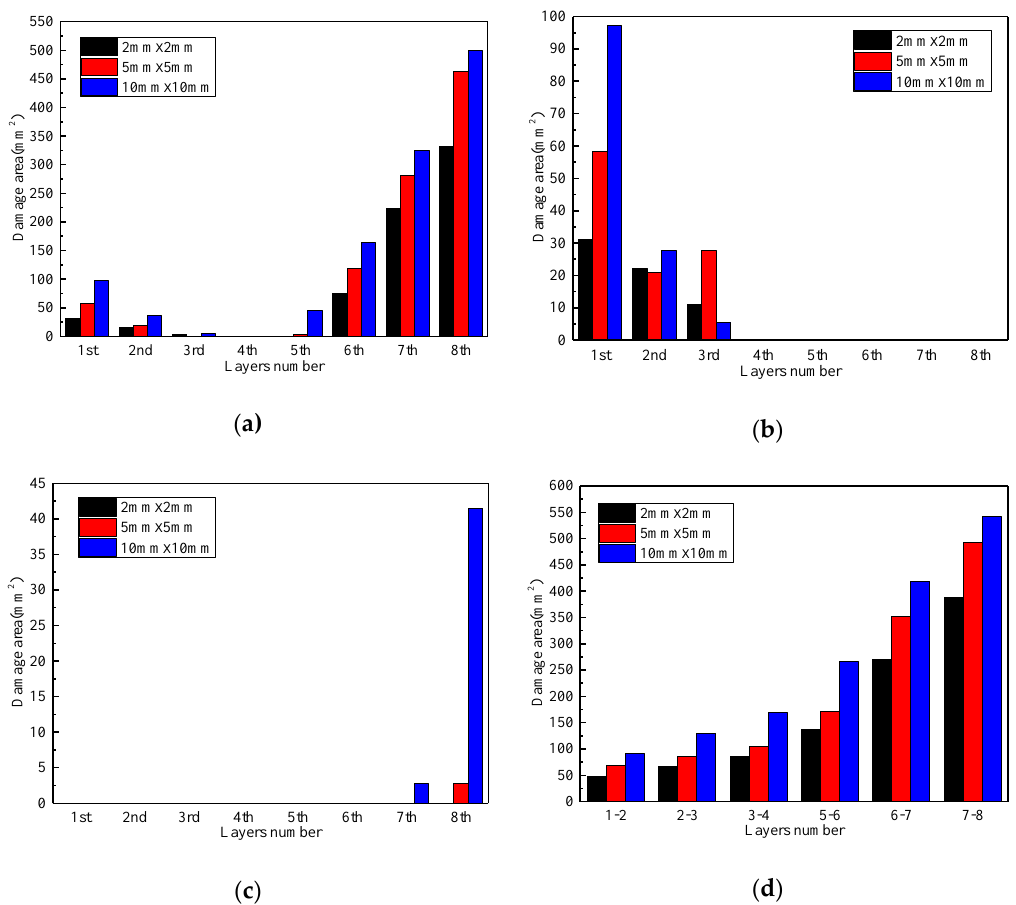
Figure 11. Distributions of different damage modes with different stitched densities after the low-velocity impact damage: ( a ) MTF; ( b ) FCF; ( c ) FTF; and, ( d ) DF.